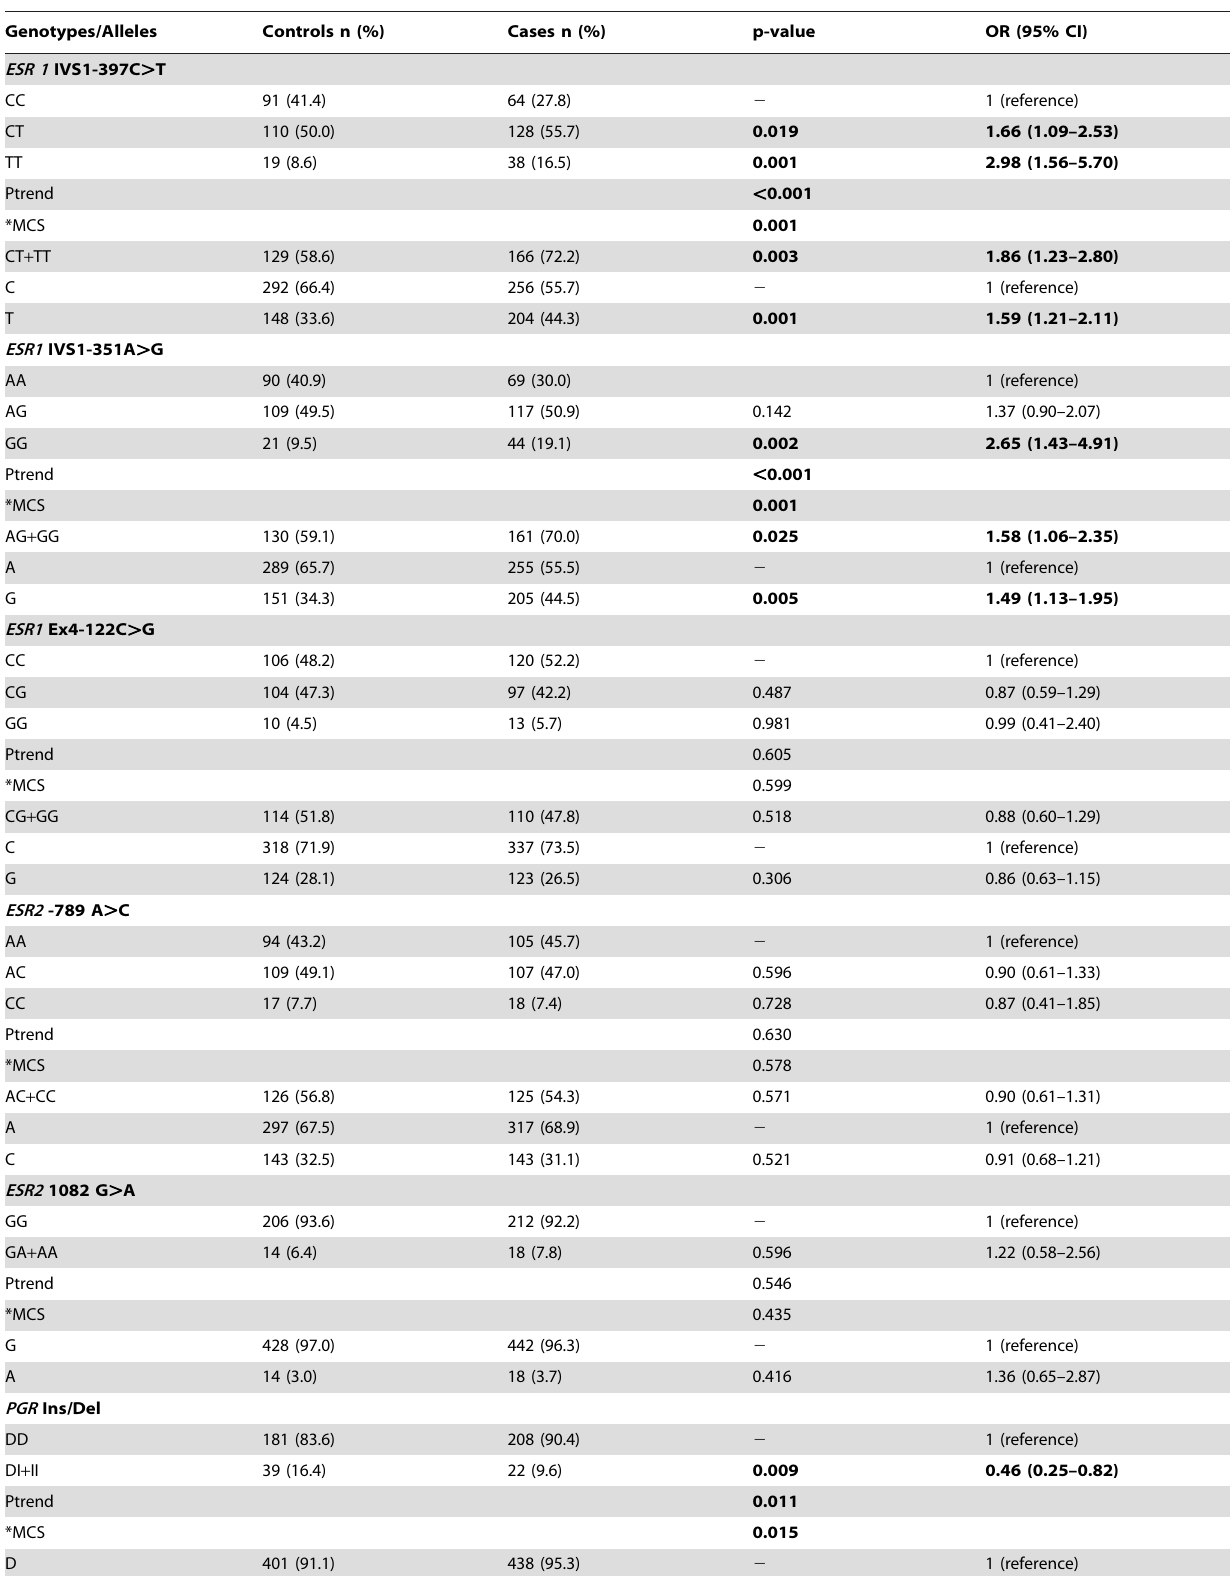
Table 2. Hormonal